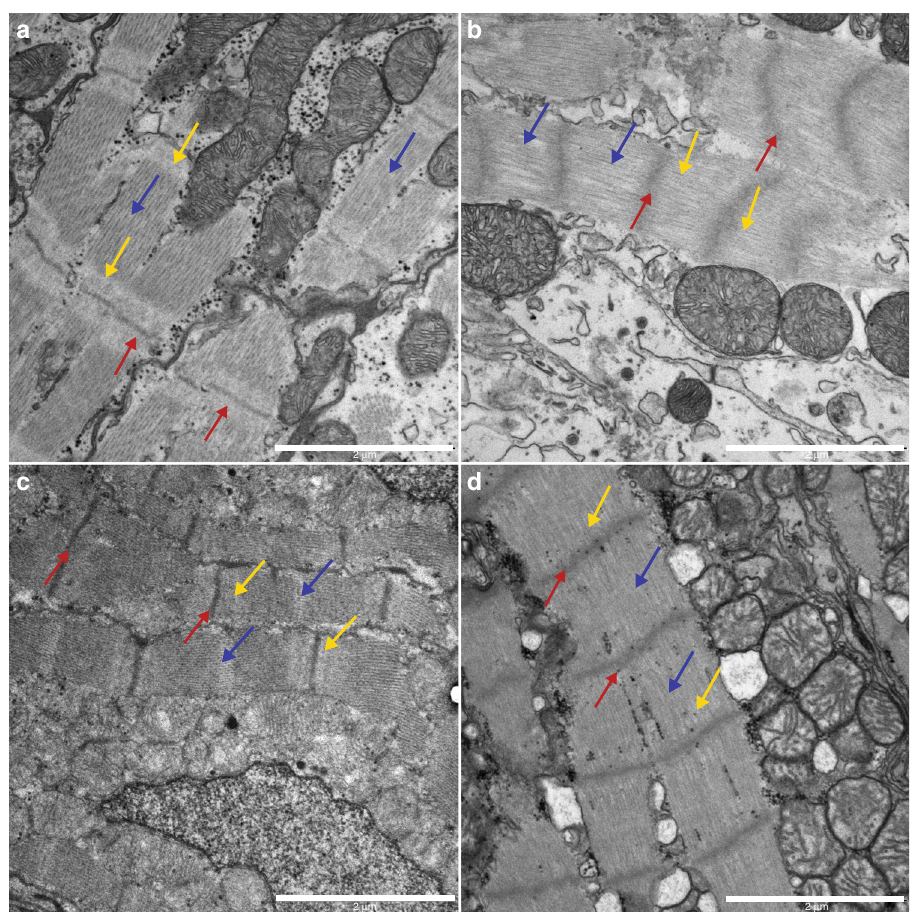
Fig. 2 Compromised sarcomere structure in adult heterozygous zebra fi sh mutants. TEM images (13,500 × ) from adult atria ( a , b ) and ventricles ( c , d ). a WT atria show well-de fi ned sarcomeres, with distinguishable Z-discs (red arrows) and I-bands (yellow arrows) throughout the tissue. Scale bar 2 µ m. b In heterozygous mutant atria the sarcomere structure is less organized. The Z-discs appear blurred (red arrows), and the I-bands are absent (yellow arrows). Scale bar 2 µ m. c Ventricle sarcomeres appear well de fi ned in WT siblings, with clear Z-discs (red arrows), I-bands (yellow arrows), and M-lines (blue arrow). Scale bar; 2 µ m. d In heterozygous mutants, there is a distinct lack of I-bands and M-lines, and the Z-discs appear blurry and increased in thickness (Scale bar; 2 µ m). The length of the sarcomeres, as measured from Z-disc to Z-disc, are signi fi cant different between WT and heterozygous in